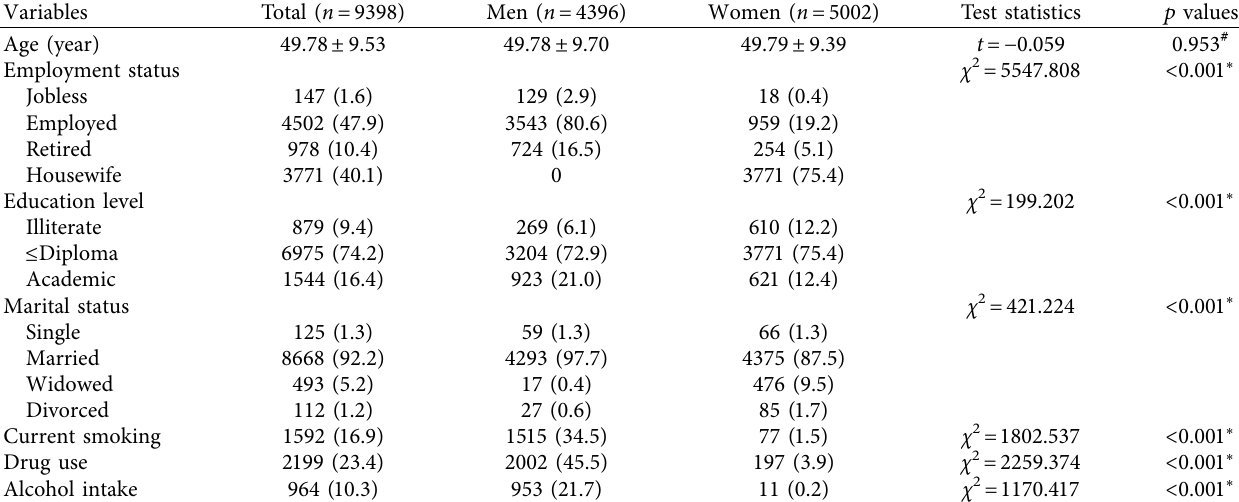
Table 1: Baseline demographic characteristics of the study participants based on gender.